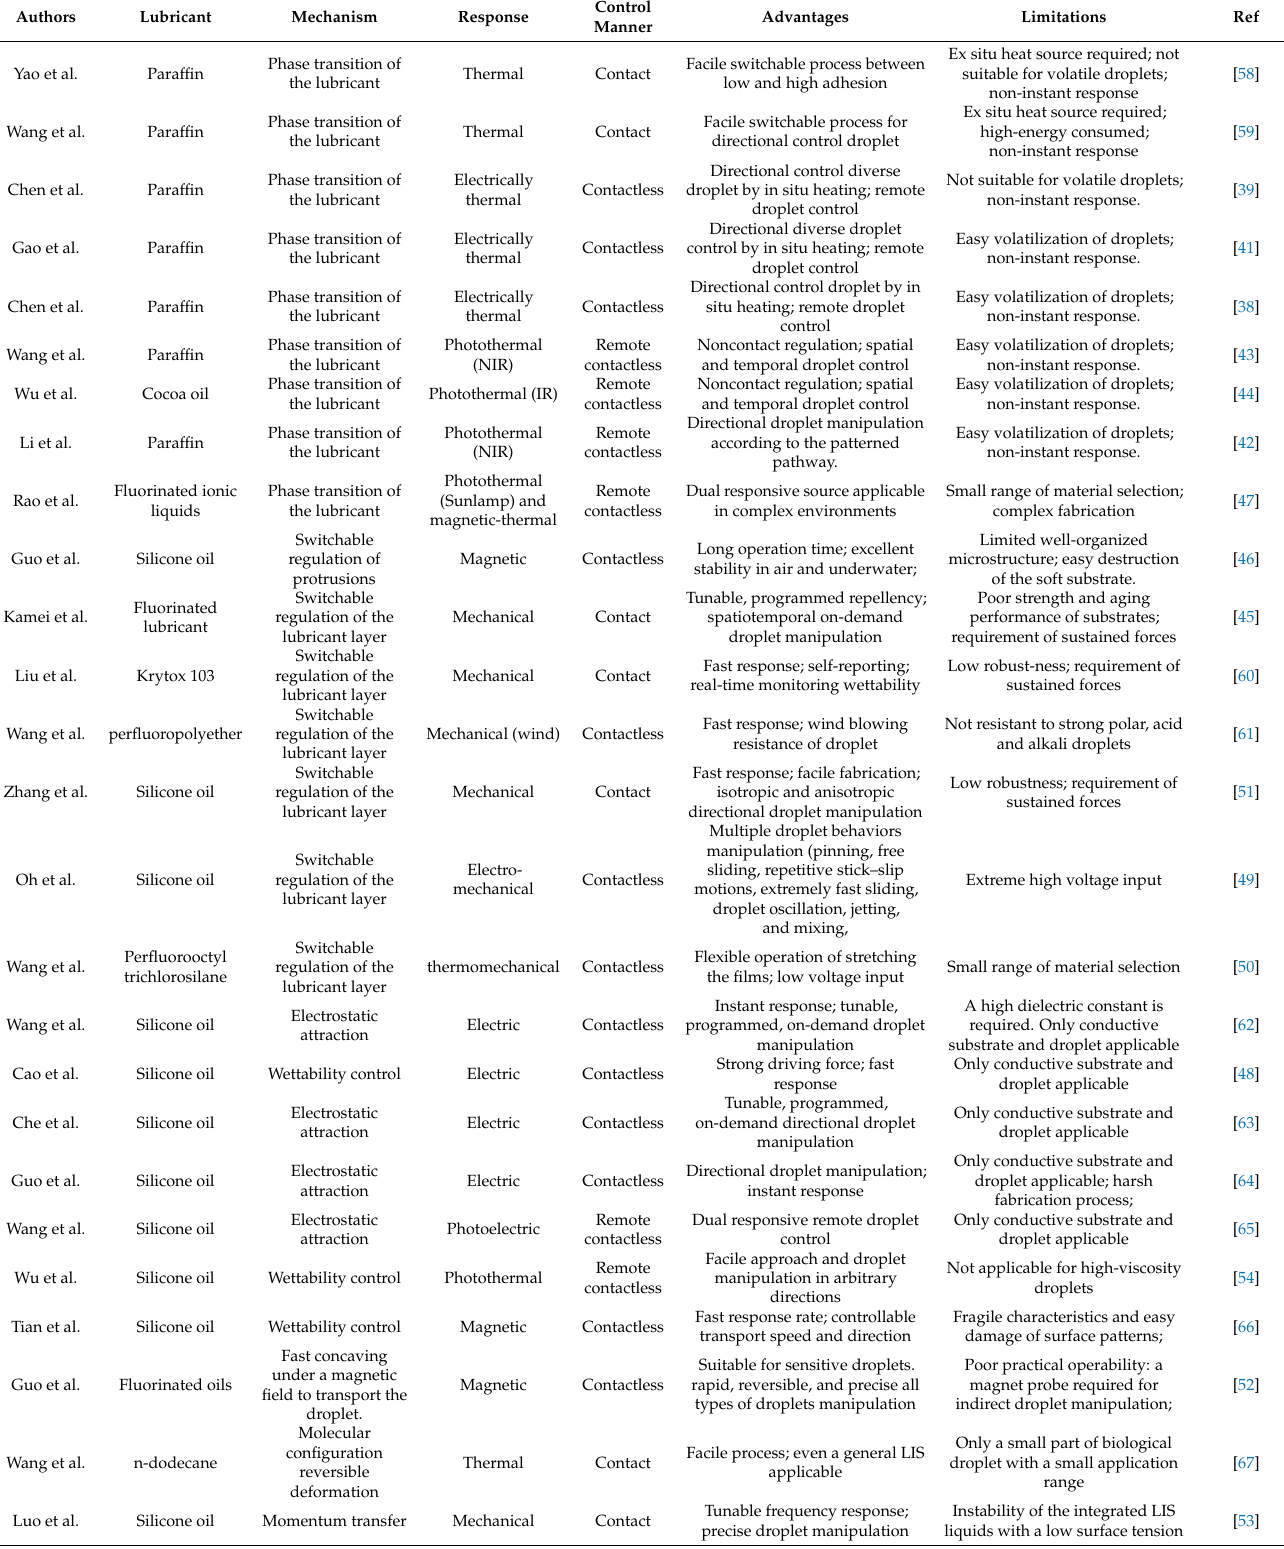
Table 1. Overview of recent advances in droplet manipulation on smart